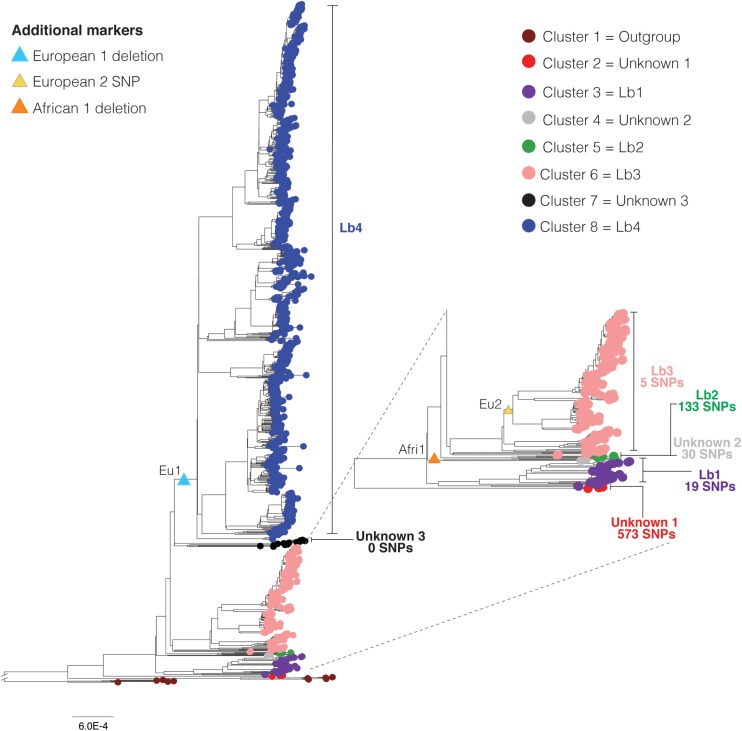
Phylogenetic clustering, SNP (single nucleotide polymorphism) markers, and lineages of Mycobacterium bovis. Maximum likelihood phylogenetic tree based on SNPs of 1,201 Mycobacterium bovis genomes (reduced dataset), using Mycobacterium caprae and Mycobacterium orygis as outgroup. Deletions and SNP correspond to the clonal complex markers European 1 (Eu1), European 2 (Eu2) and African 1 (Af1), indicated by triangles. Seven M. bovis clusters (2 through 8) were identified using TreeCluster (Balaban et al., 2019) and they are indicated by colored tips. Cluster 1 corresponds to the outgroup composed of M. orygis and M. caprae genomes. Cluster 1 was reported by TreeCluster as being two separated clusters (one for M. orygis and one for M. caprae genomes). In this figure we colored these clusters as one to facilitate visualization and understanding. Clusters 2–8 correspond to M. bovis genomes. Vertical bars indicate the number of unique SNPs in each cluster. Sixty-eight unique SNPs were also found among M. bovis genomes of the Eu2 clonal complex. The cluster “unknown 3” shares 33 SNPs with clusters 2, 3, 4, 5, and 6. Branch lengths of outgroups were reduced to improve visualization of the figure. Subtree is depicted separately to improve its visualization. Phylogenetic tree was generated using IQ-Tree with 1,000 bootstrap replicas and annotated using Iroki (Moore et al., 2019) and Adobe Illustrator. Bootstrap replicas of discussed nodes are all ≥90% and can be visualized in Supplementary Figure S2. Bar shows substitutions per nucleotide.